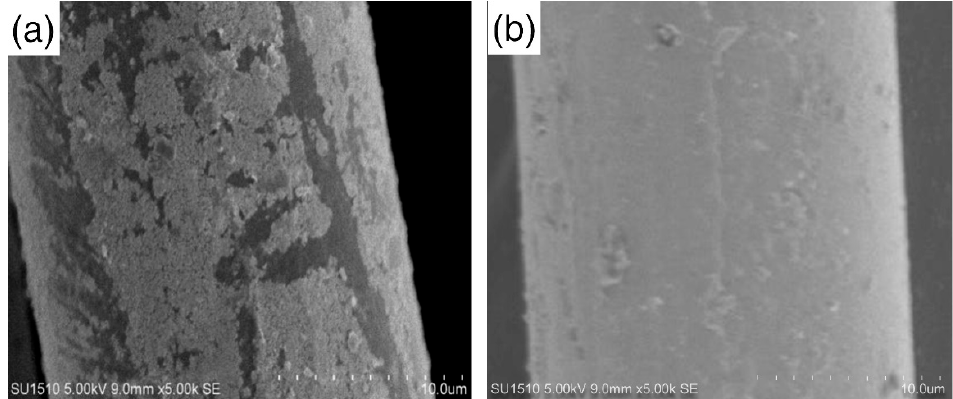
Figure 9. SEM images of conductive polyester fibers after being washed for 30 times: ( a ) electroless silver-plated fibers; ( b ) electroplated silver-plated fibers.